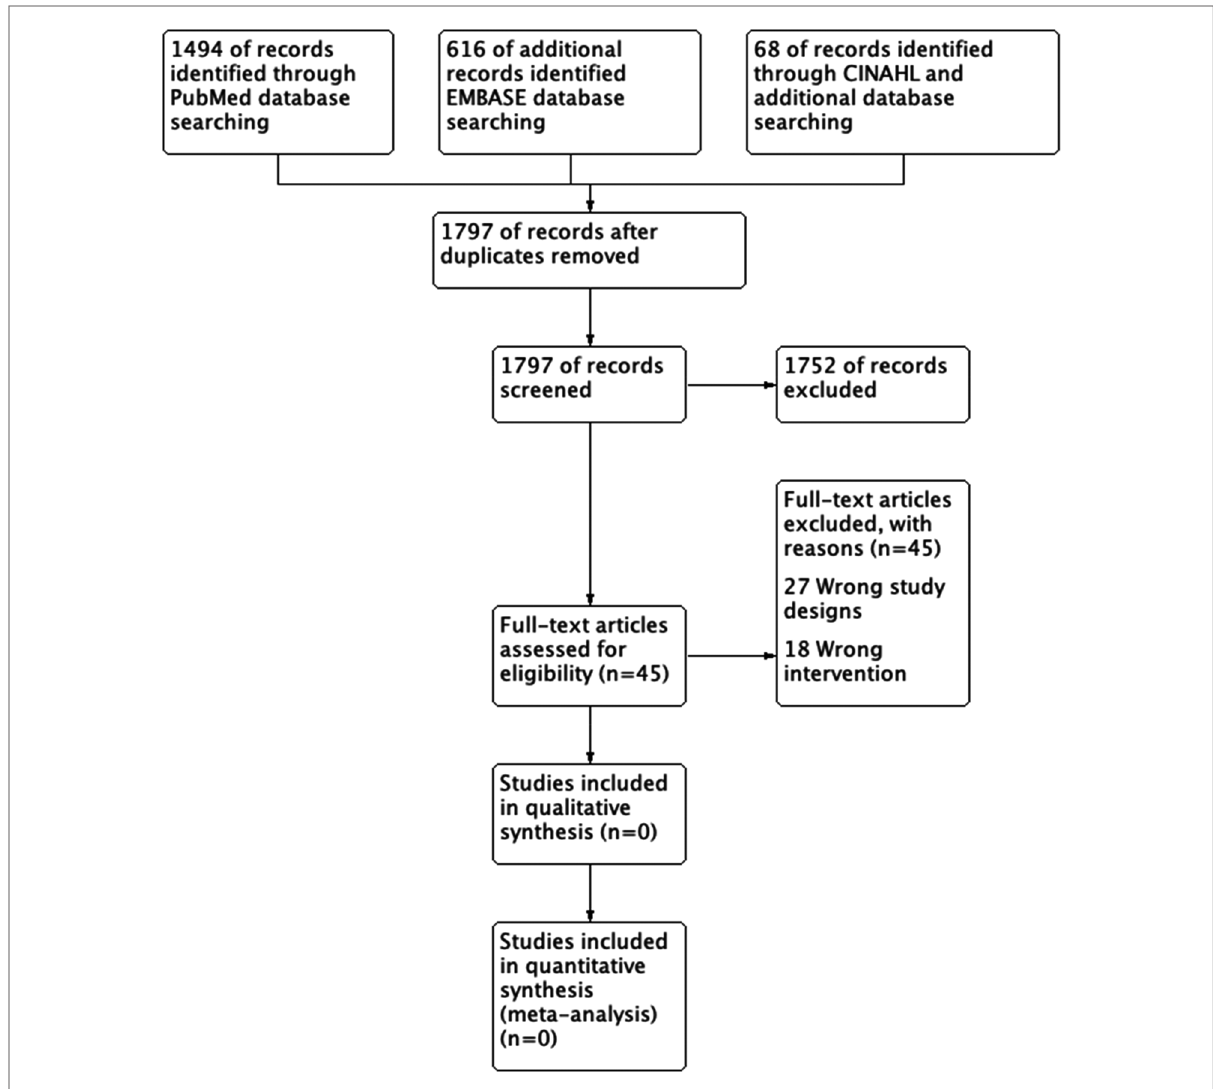
FIGURE 1 PRISMA study fl ow